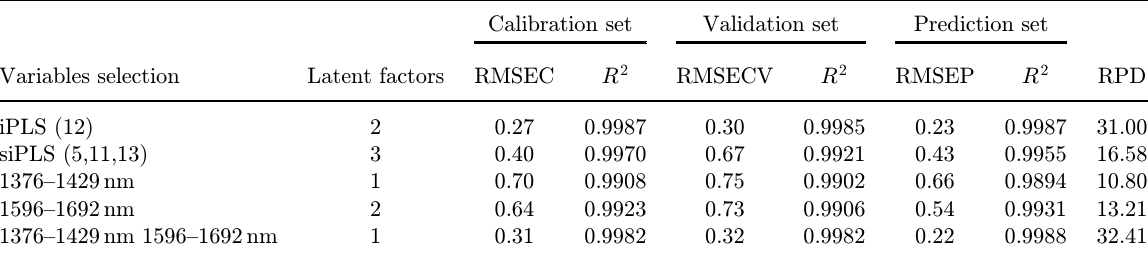
Table 2. The evaluation parameters of PLS